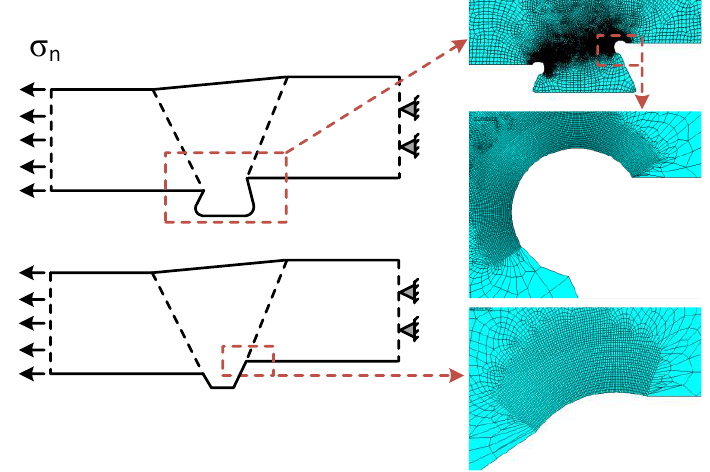
Figure 4. Finite element model for the estimation of the effective notch stress.